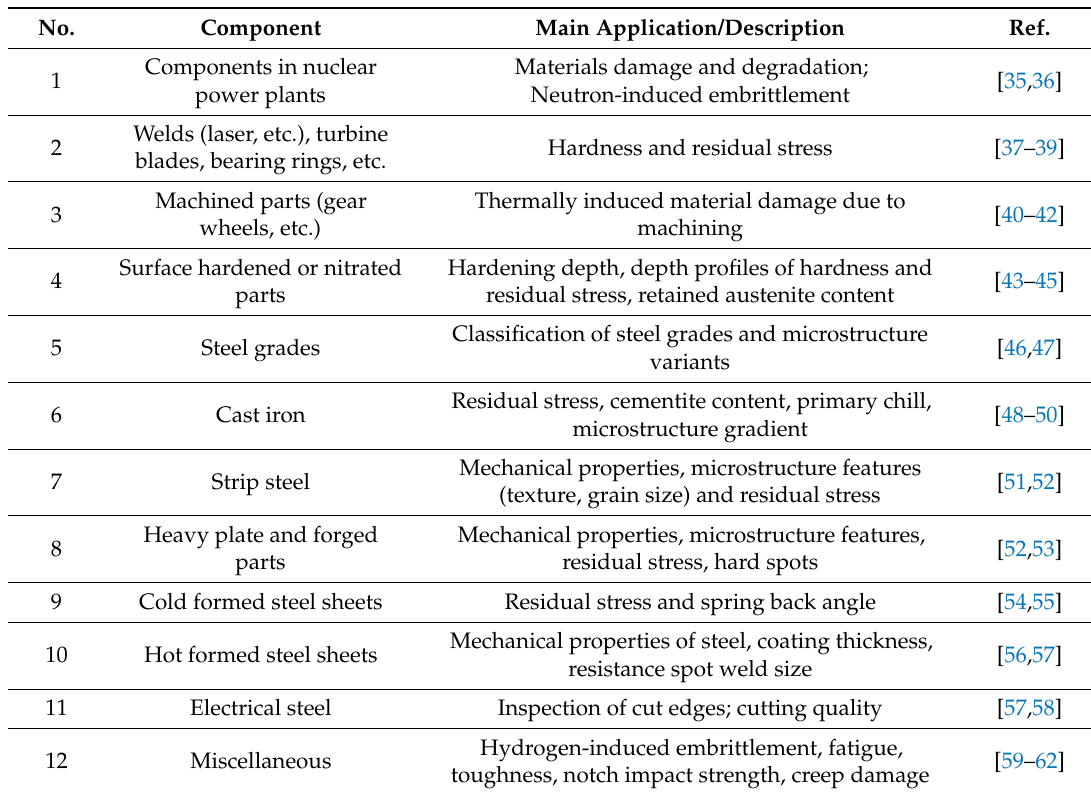
Table 5. Overview of possible 3MA